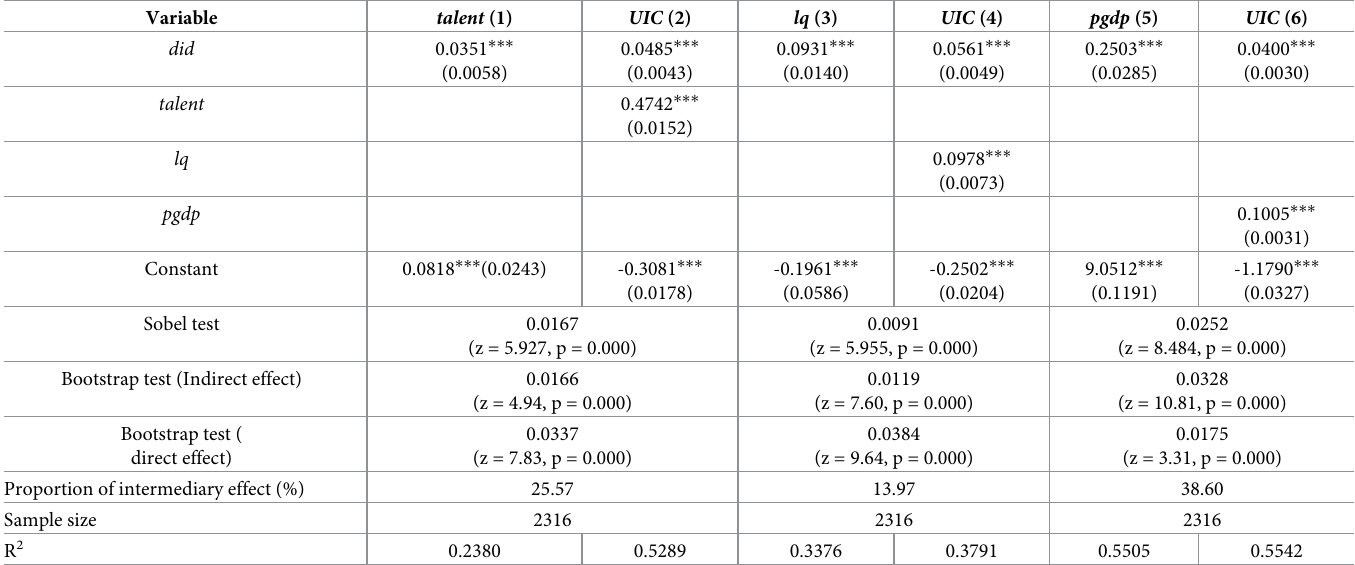
Table 7. Intermediary effect